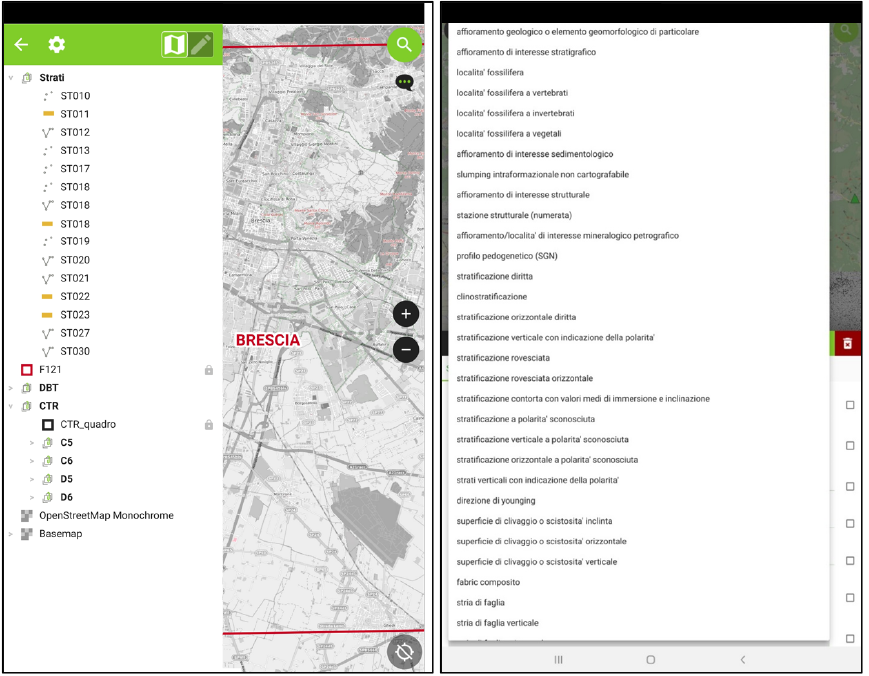
Figure 4. QField mobile survey activity sample on the mobile device. Left panel: main project and menu with layers and additional data. Right panel: list of the “type” attributes for the geological observation layer (ST019). Table 1. The list of layers composing the CARG database used during the fieldwork. The original structure of the CARG database is much more complex and includes many other layers. A selection was made in advance in order to choose the fundamental layers that must be characterized in the